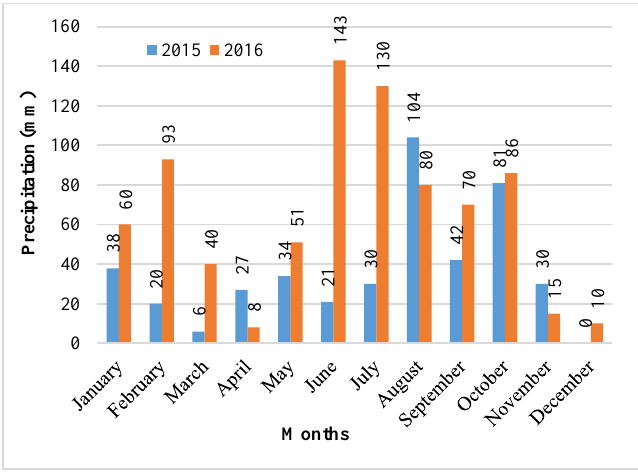
Figure 1. Precipitation of the experimental site (Debrecen-Pallag, 2015-2016) Measured parameters